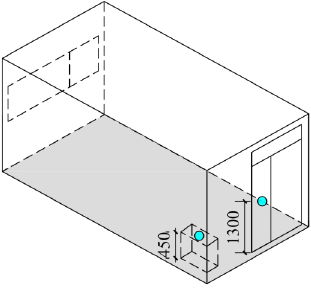
Figure 4. The location of the temperature measuring point in the experimental CH.